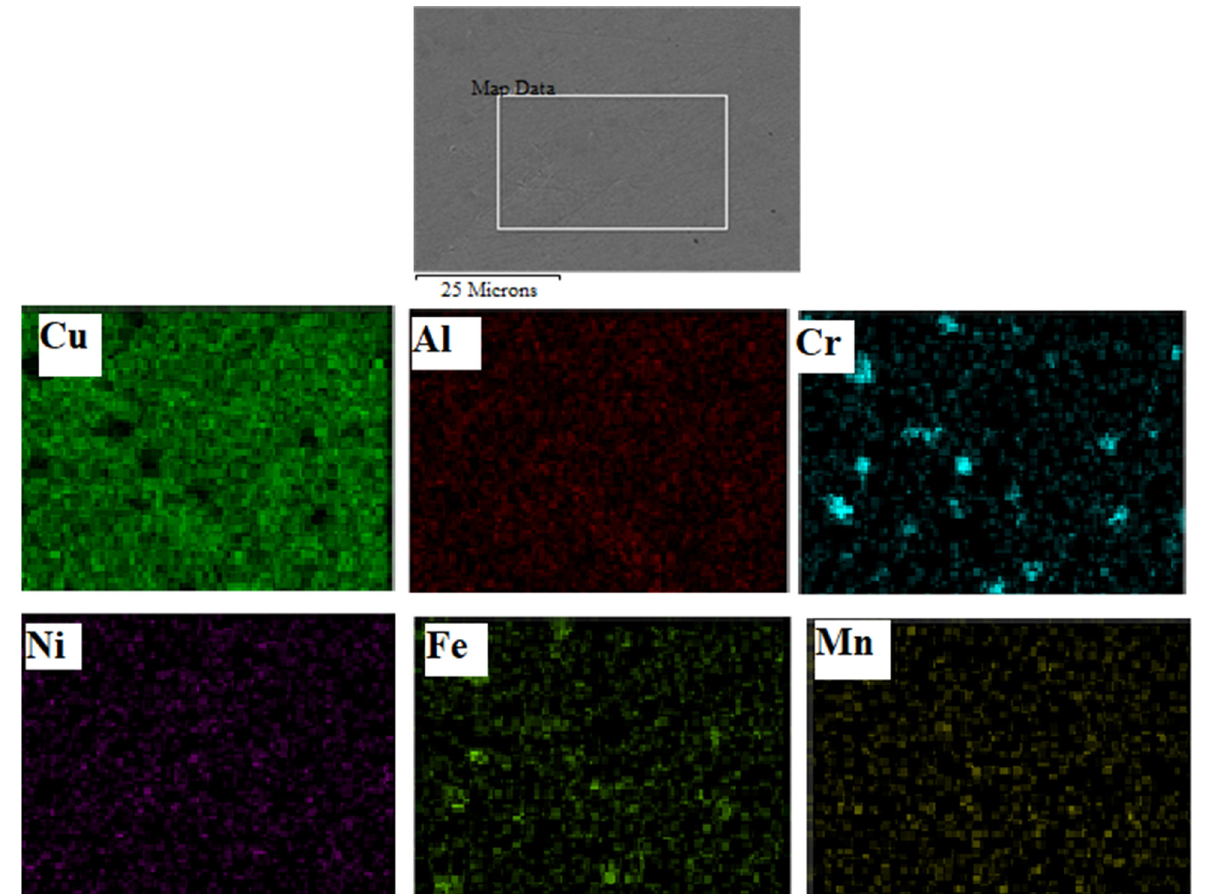
Figure 9. EDS mapping of all of the elements in the FSPed composite.